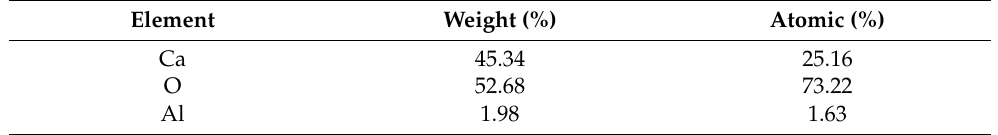
Figure 9. The EDS micrographs of BF 0.5 -Al after the 1st calcination: ( a ) scanning area; ( b ) the distribution of Ca atom; ( c ) the distribution of O atom; and ( d ) the distribution of Al atom. Table 4. The quantitative result of elements in BF 0.5 -Al from EDS analysis.